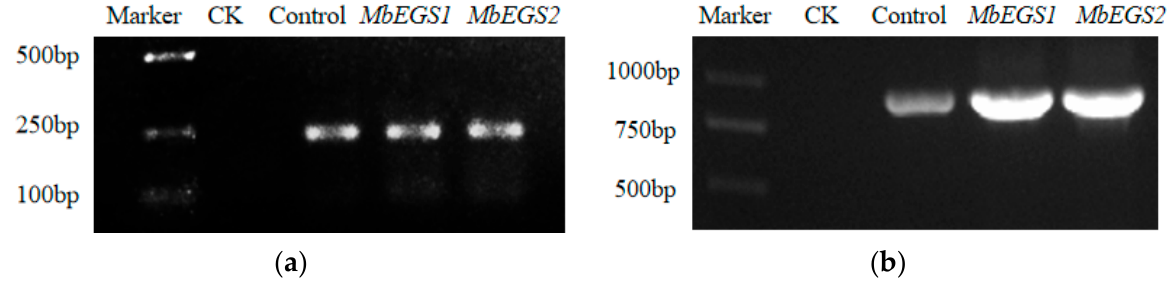
Figure 2. PCR results for the GUS reporter gene ( a ) and TRV virus detection ( b ).